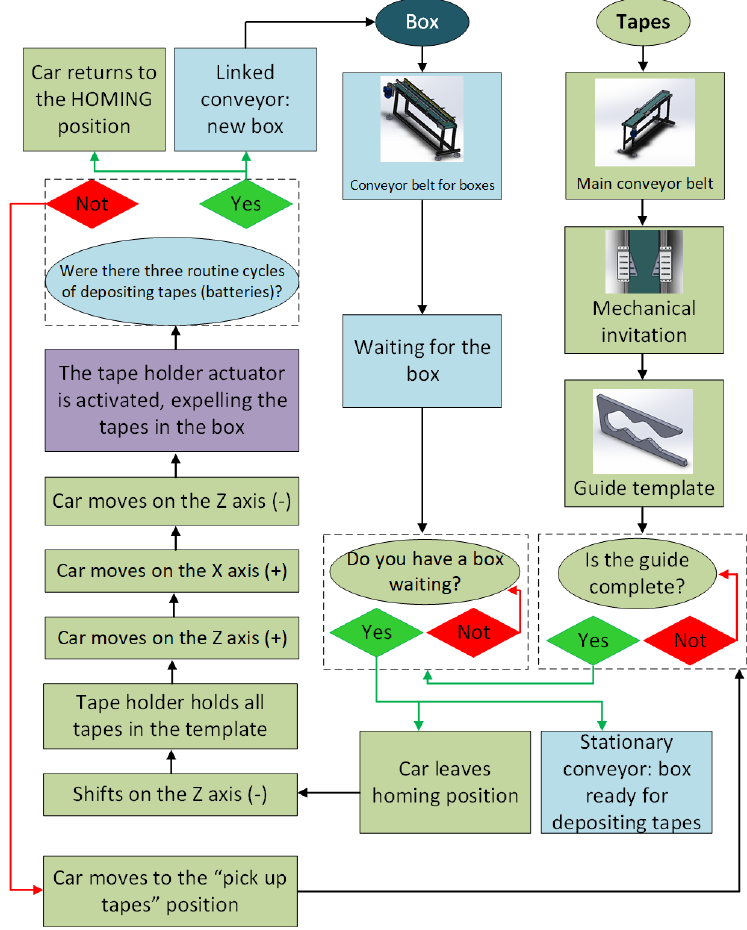
Figure 5. Flowchart of operation of the Guzzetti packaging